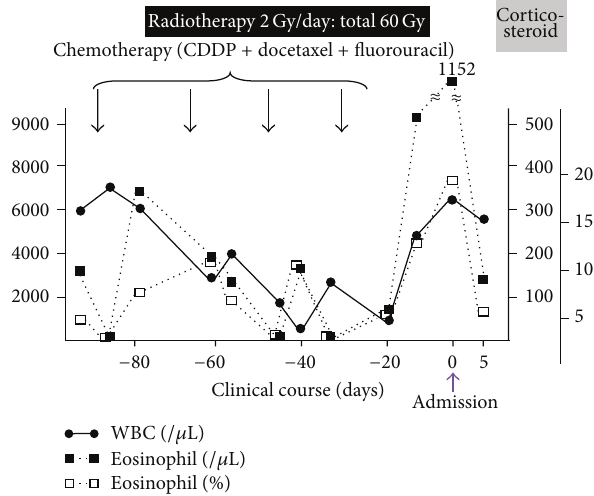
Figure 2: Clinical course. Note that percentage (open squares) and absolute number (closed squares) of peripheral eosinophil transiently increased just after the serial administration of anti- cancer drugs and it dramatically increased after the 4th course of the chemotherapy. Eosinophil dramatically decreased after the administration of